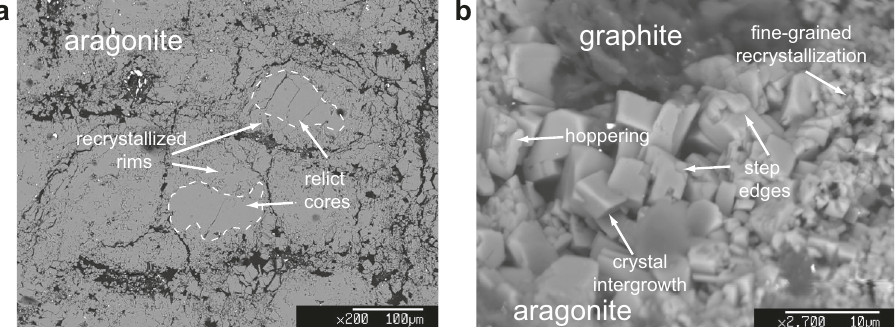
Fig. 1 Electron microscope images showing microtextures of run products. a Recrystallized aragonite, showing rims of sub-micrometric crystals surrounding relict cores 50 – 100 µ m in size. b Assemblage graphite + aragonite; aragonite crystals show dissolution/reprecipitation microtextures such as crystal size reduction, hoppering, step edges and euhedral crystal